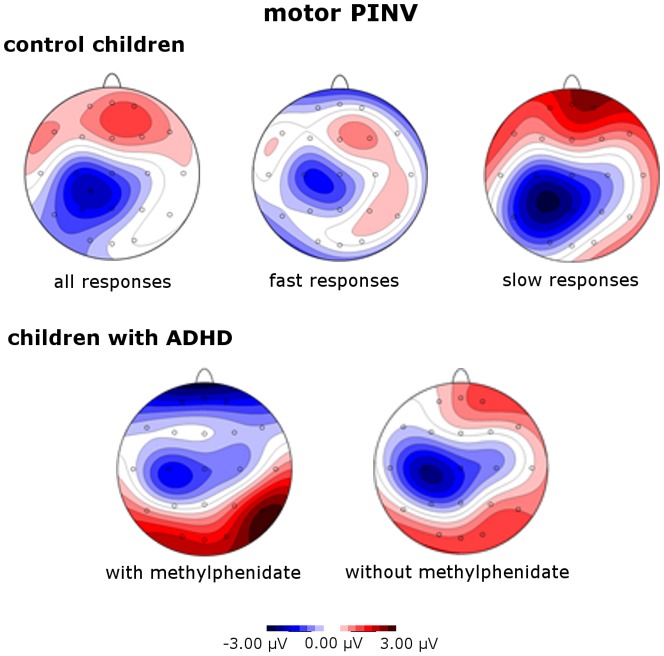
Motor PINV topography for healthy control children.(top; from left to right: all responses, fast responses below median reaction time, slow responses above median reaction time) and children with ADHD (bottom; from left to right: responses off and on methylphenidate) for the motor PINV time interval (500–800 ms after the response trigger, motor post-processing).